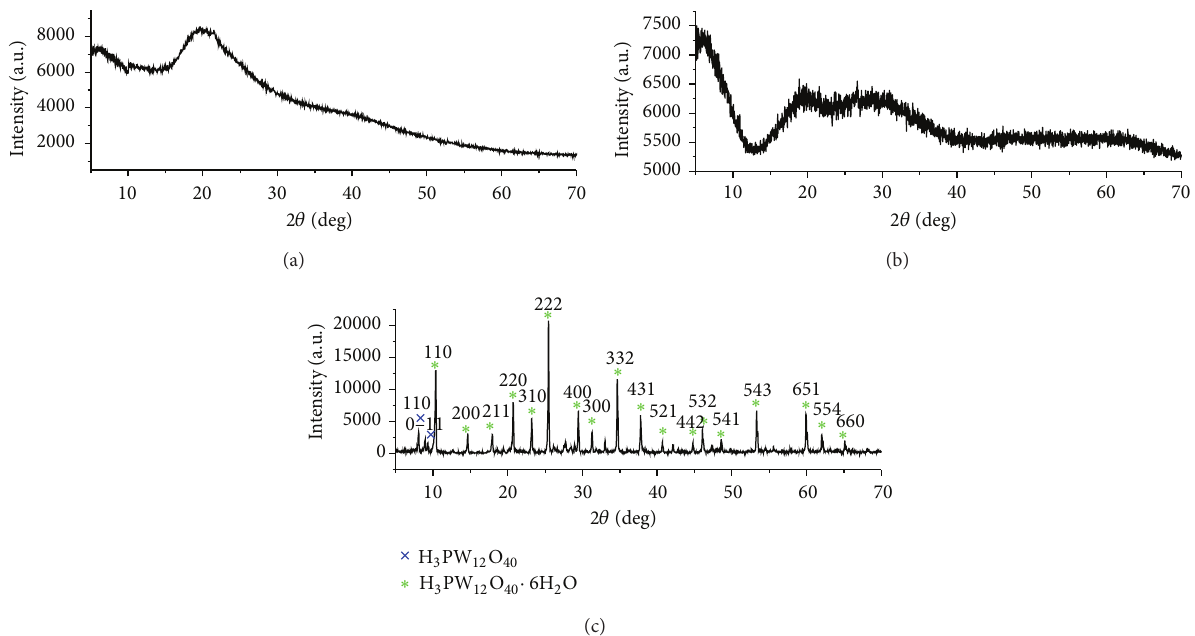
Figure 3: XRD patterns of (a) yeast, (b) HPW@yeast, and (c)